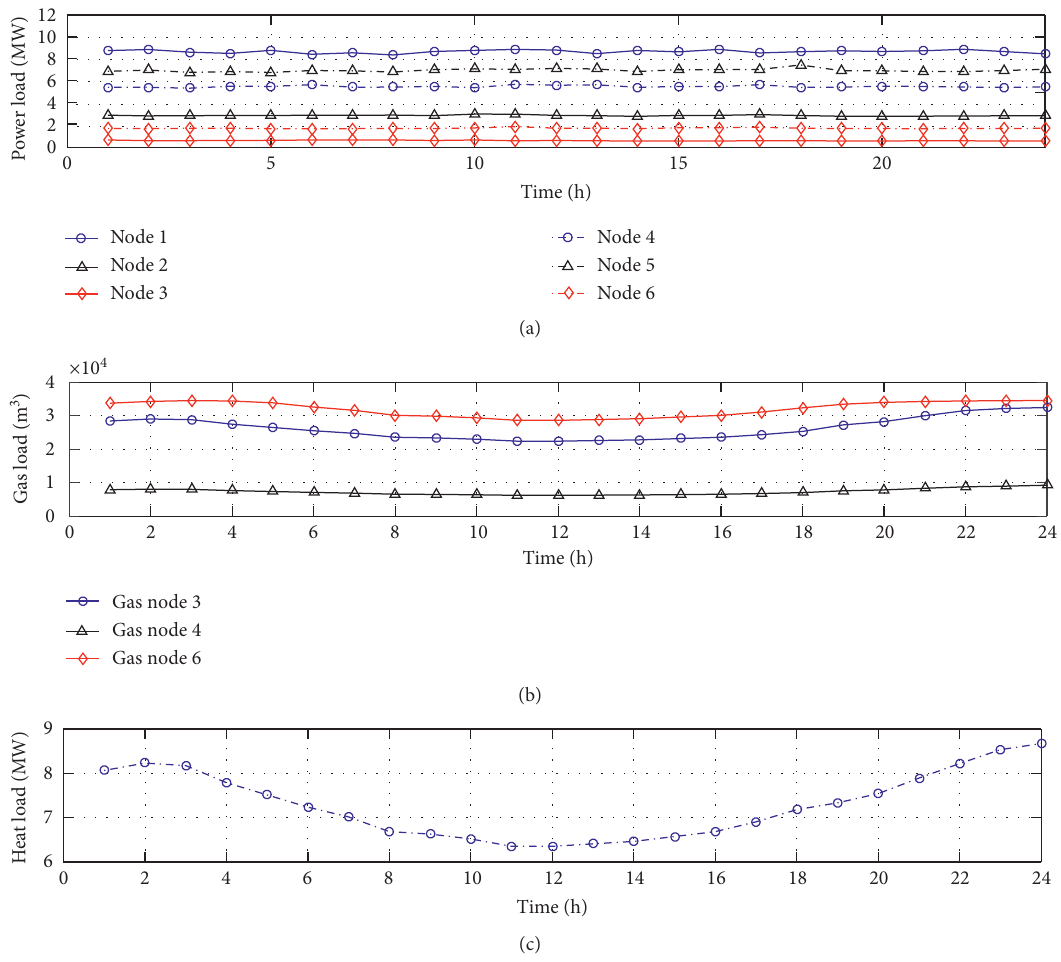
Figure 3: Different load forecast